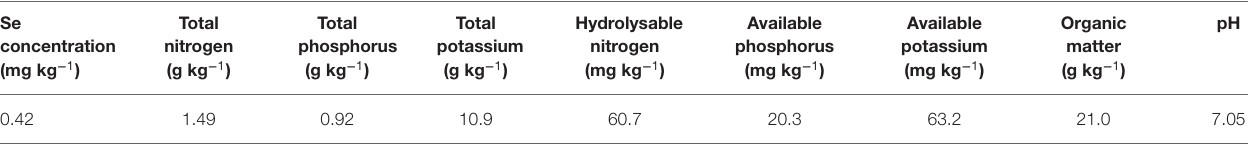
TABLE 1 | Physicochemical properties (dry weight) of the paddy soil used in this study. Se concentration